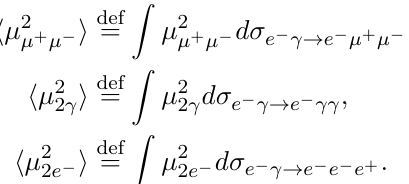
Cross section averaged square of the µ + µ − pair in- variant mass, in units m 2 , as µ √ function of s/m µ .